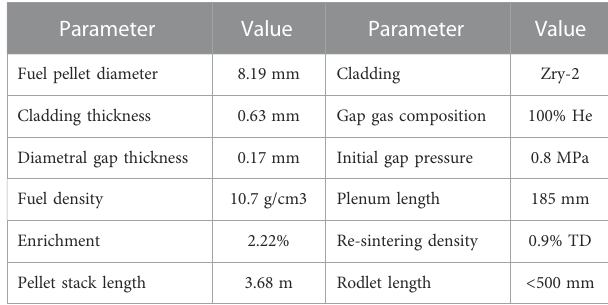
TABLE 1 Father rod and fuel rodlet